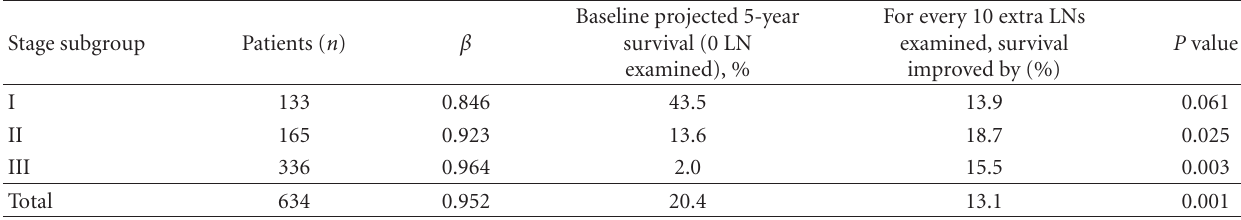
Table 5: Projected numeric total LNs impact on 5-year overall survival.